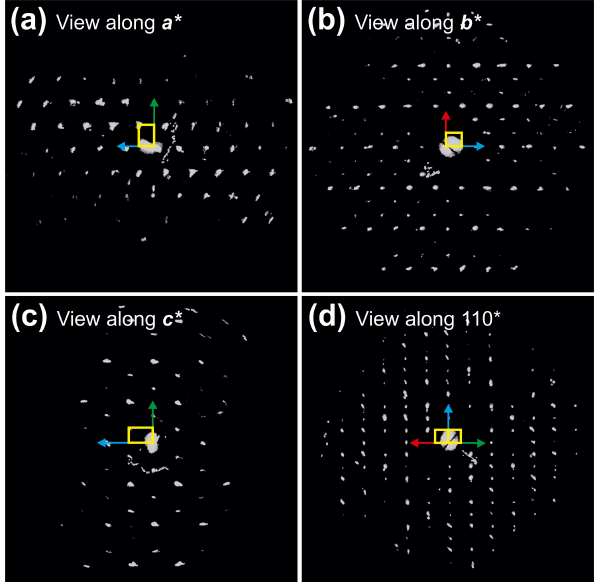
Figure 5. Crystal structure of badengzhuite. (a) View along c; (b) view along b. Table 4. Atomic coordinates for badengzhuite.